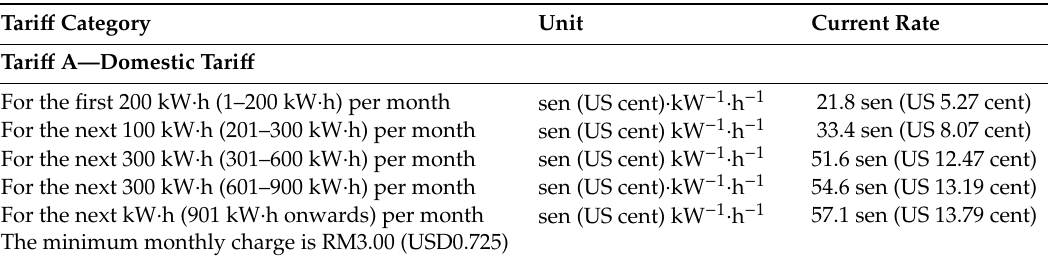
Table 6. TNB Domestic Electricity Tari ff Rates